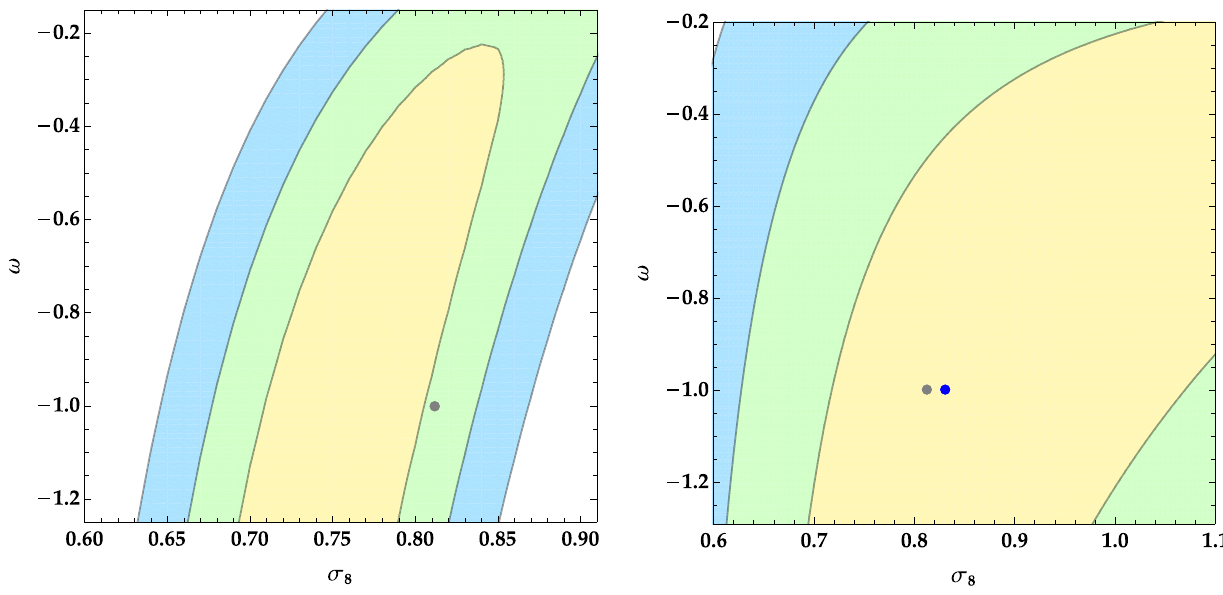
Fig. 3 w vs. σ 8 1 σ , 2 σ and 3 σ confidence regions. Left: maximized contours with Ω m = 0 . 3166. The Planck 2018 point lays at 1 . 19 σ . Right: marginalized contours. The blue point corresponds to Planck 2015 and lays at 0 . 26 σ and the grey point corresponds to Planck 2018 and lays at 0 . 33 σ